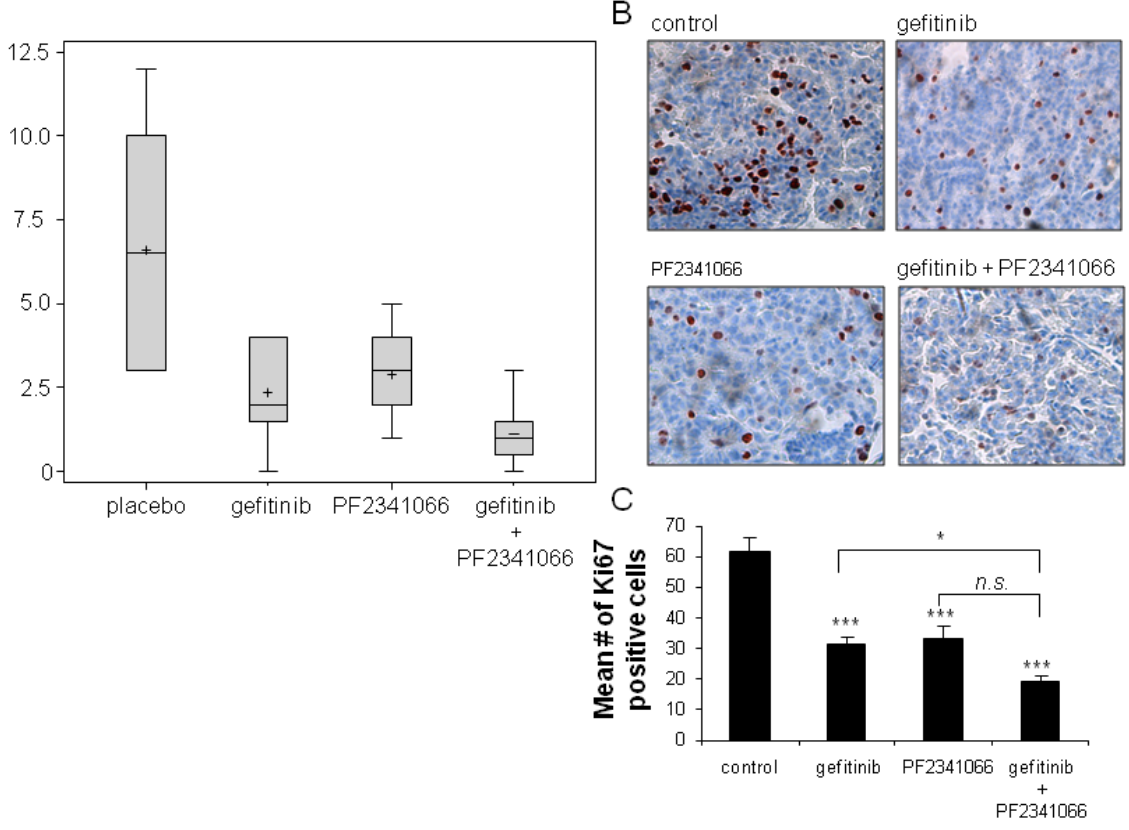
showing immunohistochemical staining for Ki67. ( C ) Quantitation for Ki67 was marker from 5-high powered fields per experimental treatment. * P <